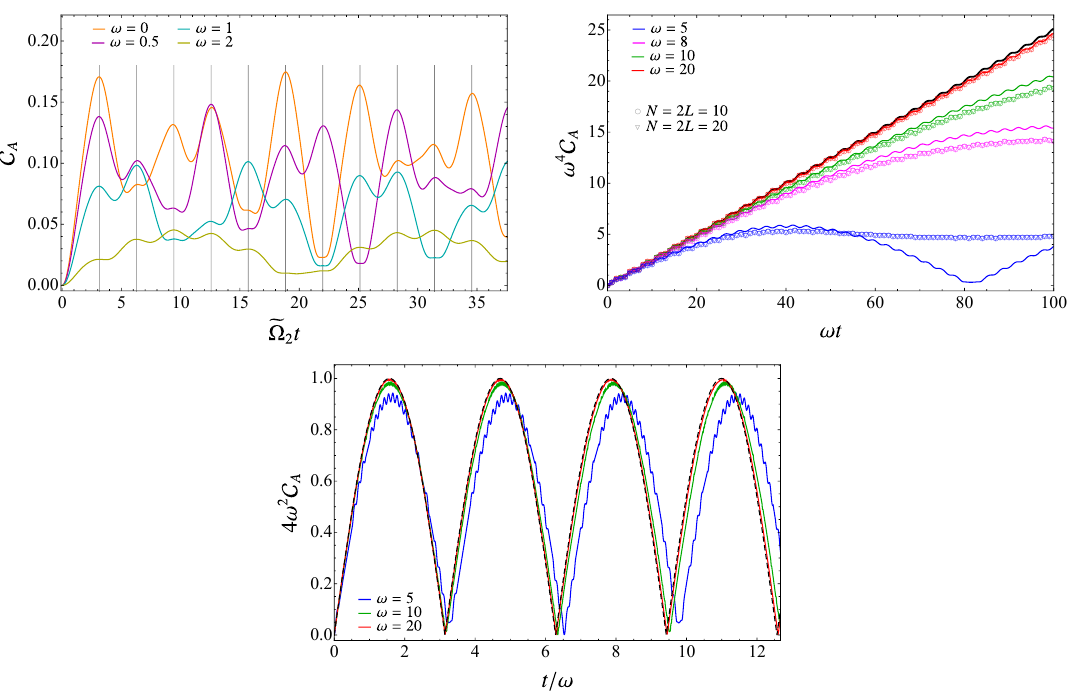
Figure 14 . Temporal evolution of the subsystem complexity C A after the local quench w.r.t. the initial state at t = 0 when A contains a single site and the chain is made by two sites. In the top left panel (4.13) is shown for small values of ω . In the top right and in the bottom panel we compare (4.13) for larger values of ω against (4.15) (black solid line) and (4.16) (black dashed line) respectively. In the top right panel, numerical data for the subsystem complexity of half chains with N > 2 are also reported. In all the panels κ = 1 and m = 1